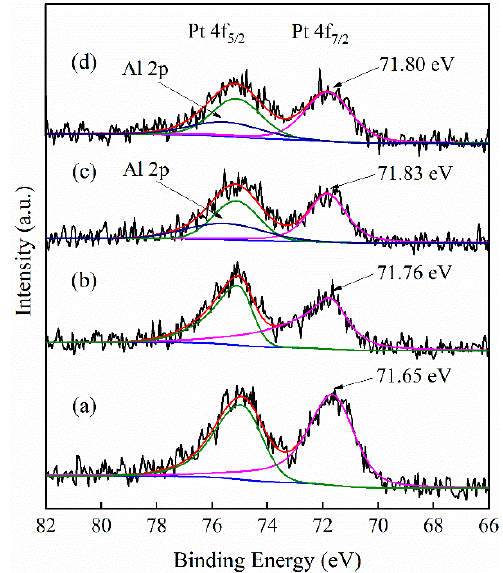
Figure 5. Pt 4f XPS spectra of ( a ) Pt/S-1, ( b ) Pt/hS-1, ( c ) Pt/hZSM-5, and ( d ) Pt/cZSM-5 catalysts.